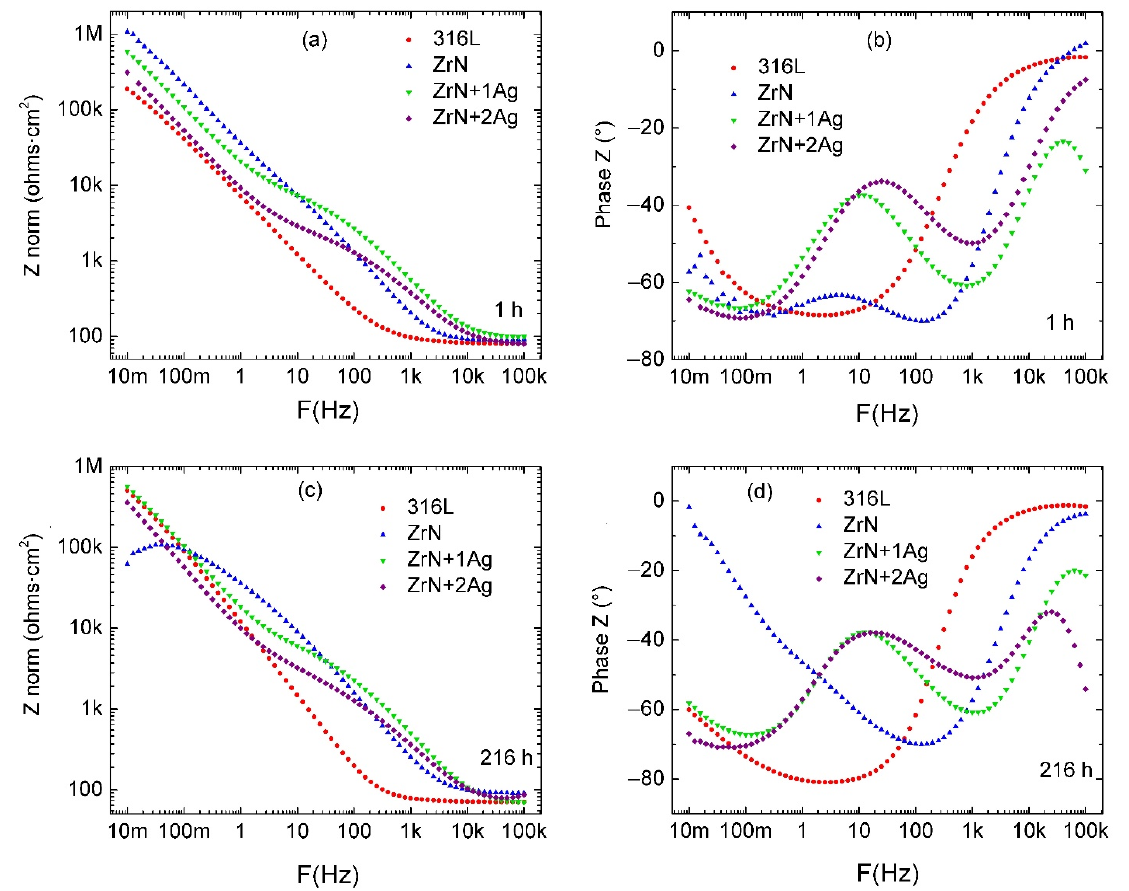
Figure 7. Electrochemical impedance test as a function of the Ag content in a Ringer’s solution at 37.5 °C. ( a ) Impedance module, ( b ) phase angle at 1 h immersion, ( c ) impedance, and ( d ) phase at 216 h